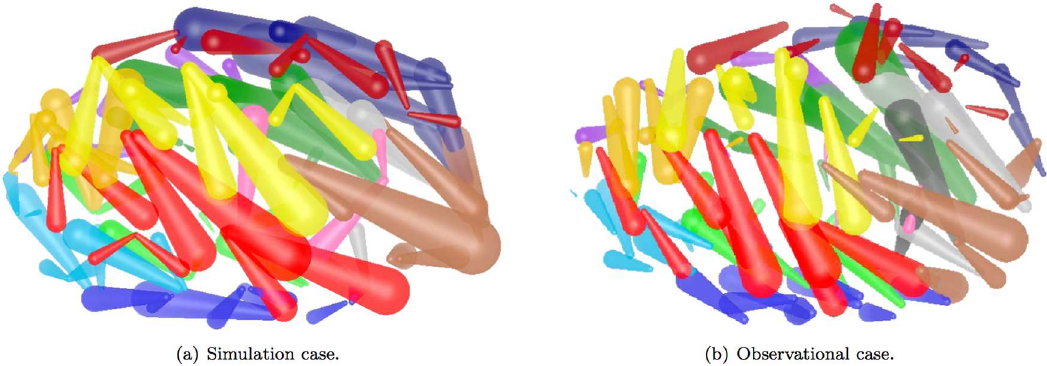
Fig 6. Cell displacement patterns during AB64 stage. 3D depth trajectories represent the movement path of cells. Different colors representthe 14 founder cells of C. elegans , which is color codedby the followingrules: ABala(light brown), ABalp(light blue), ABara(light purple), ABarp(yellow), ABpla(red), ABplp(dark blue), ABpra(magenta), ABprp(dark purple), MSa(light green), MSp(dark green), E(pink), C(dark brown), D(light gray), P(dark gray).